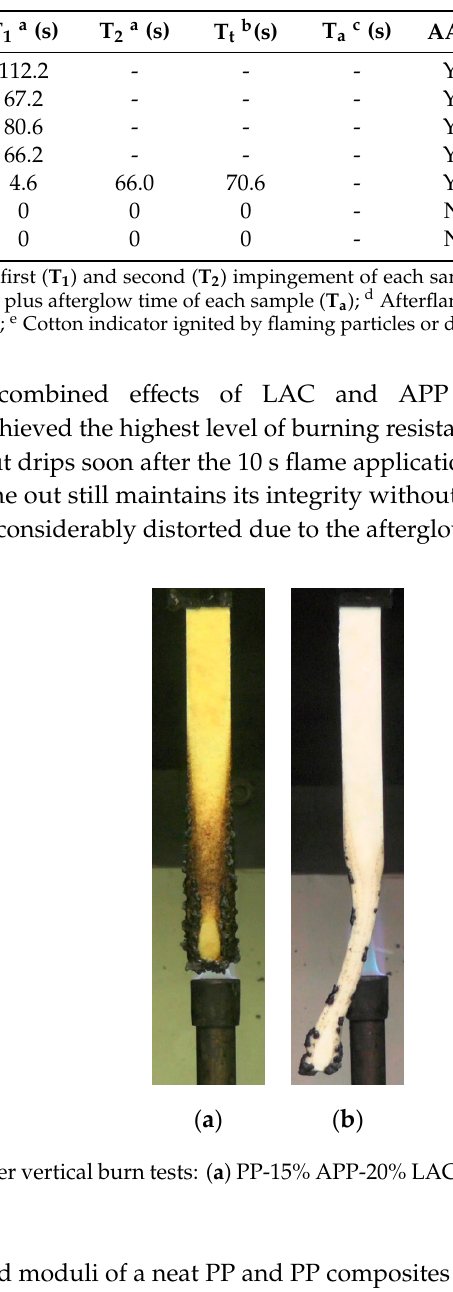
Figure 10. Samples after vertical burn tests: ( a ) PP-15% APP-20% LAC and ( b ) PP-20% APP composites. 3.6. Tensile Properties Tensile strengths and moduli of a neat PP and PP composites are demonstrated in Figure 11. As PP composites, PP-30LAC, PP-15APP-20LAC, PP-15APP, and PP-20APP were chosen to understand the effect of LAC on tensile properties. The addition of 20 wt% of LAC with 15 wt% of APP improves the stiffness of the composite by 23% compared to a neat PP. Moreover, the improvement of the stiffness by the combination of LAC and APP was better than one of PP composites including APP only. On the other hand, the adverse effects of the casein on the tensile strength are identified. It can be considered that the particle size (310 µm) and loading of LAC affected the reduction of tensile strength values of the PP-30LAC and PP-15APP-20LAC composites [37,38]. Additionally, the hydrophilic LAC might cause a poor compatibility with the hydrophobic polymer [39]. The relative